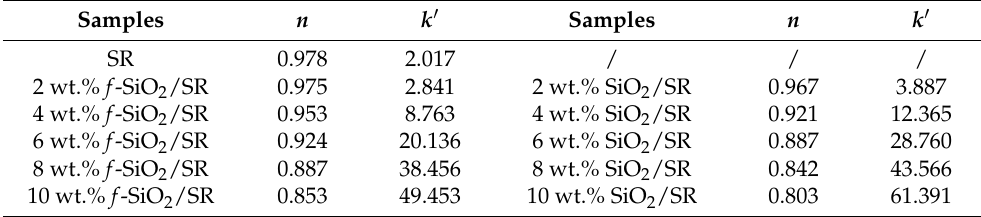
Table 2. The power law parameters of f -SiO 2 /SR and SiO 2 /SR